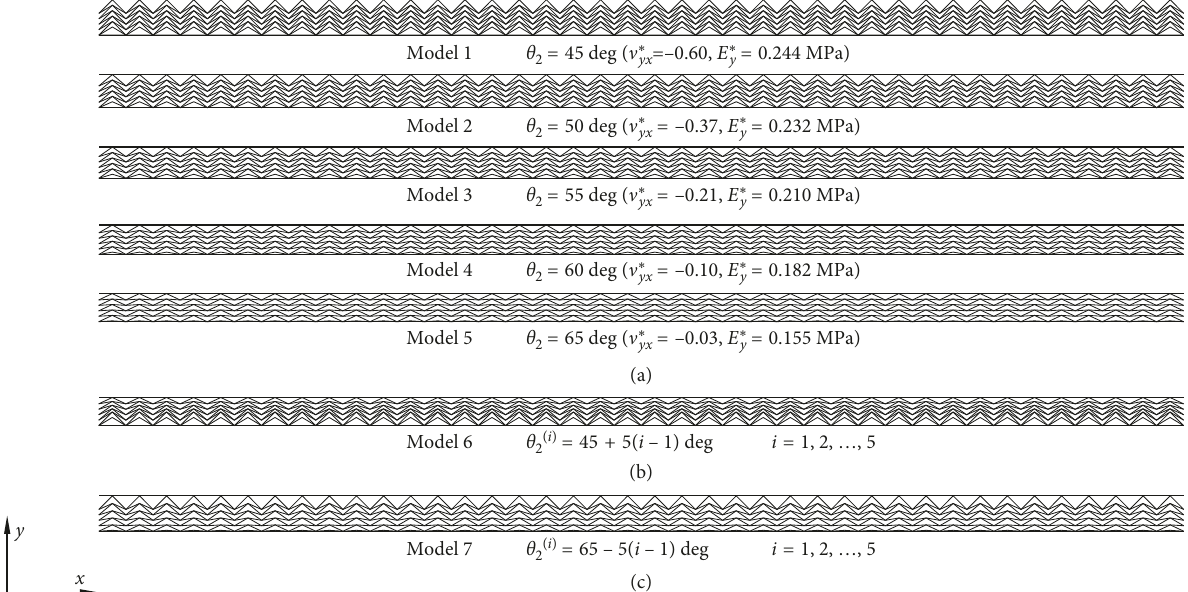
Figure 2: Sandwich panels with DAH cores from models 1 to 7: (a) the uniform models; (b) the gradient DNPR models; (c) the gradient INPR